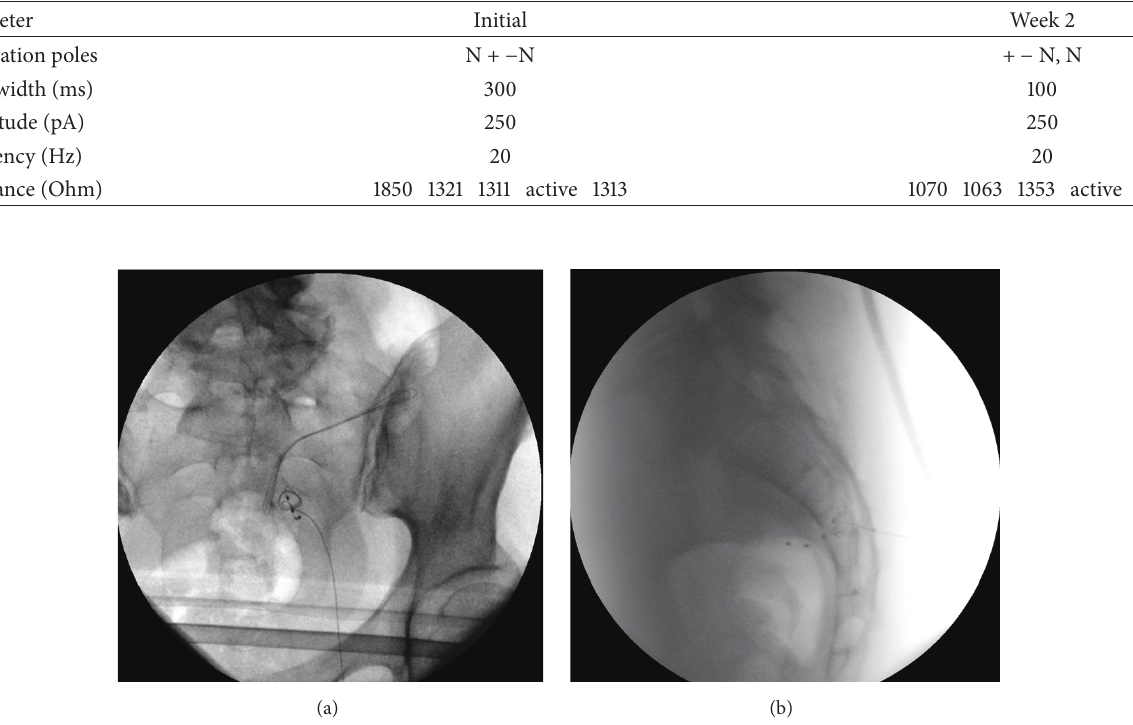
Figure 1: (a) AP view S3 lead placement with epidural loops. (b) Lateral view S3 lead placement with epidural